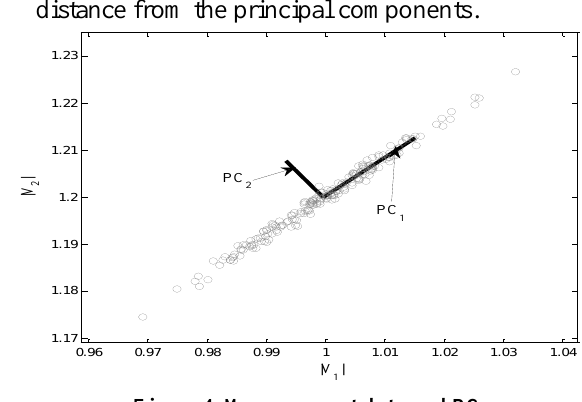
Figure 4. Measurement data and PCs.